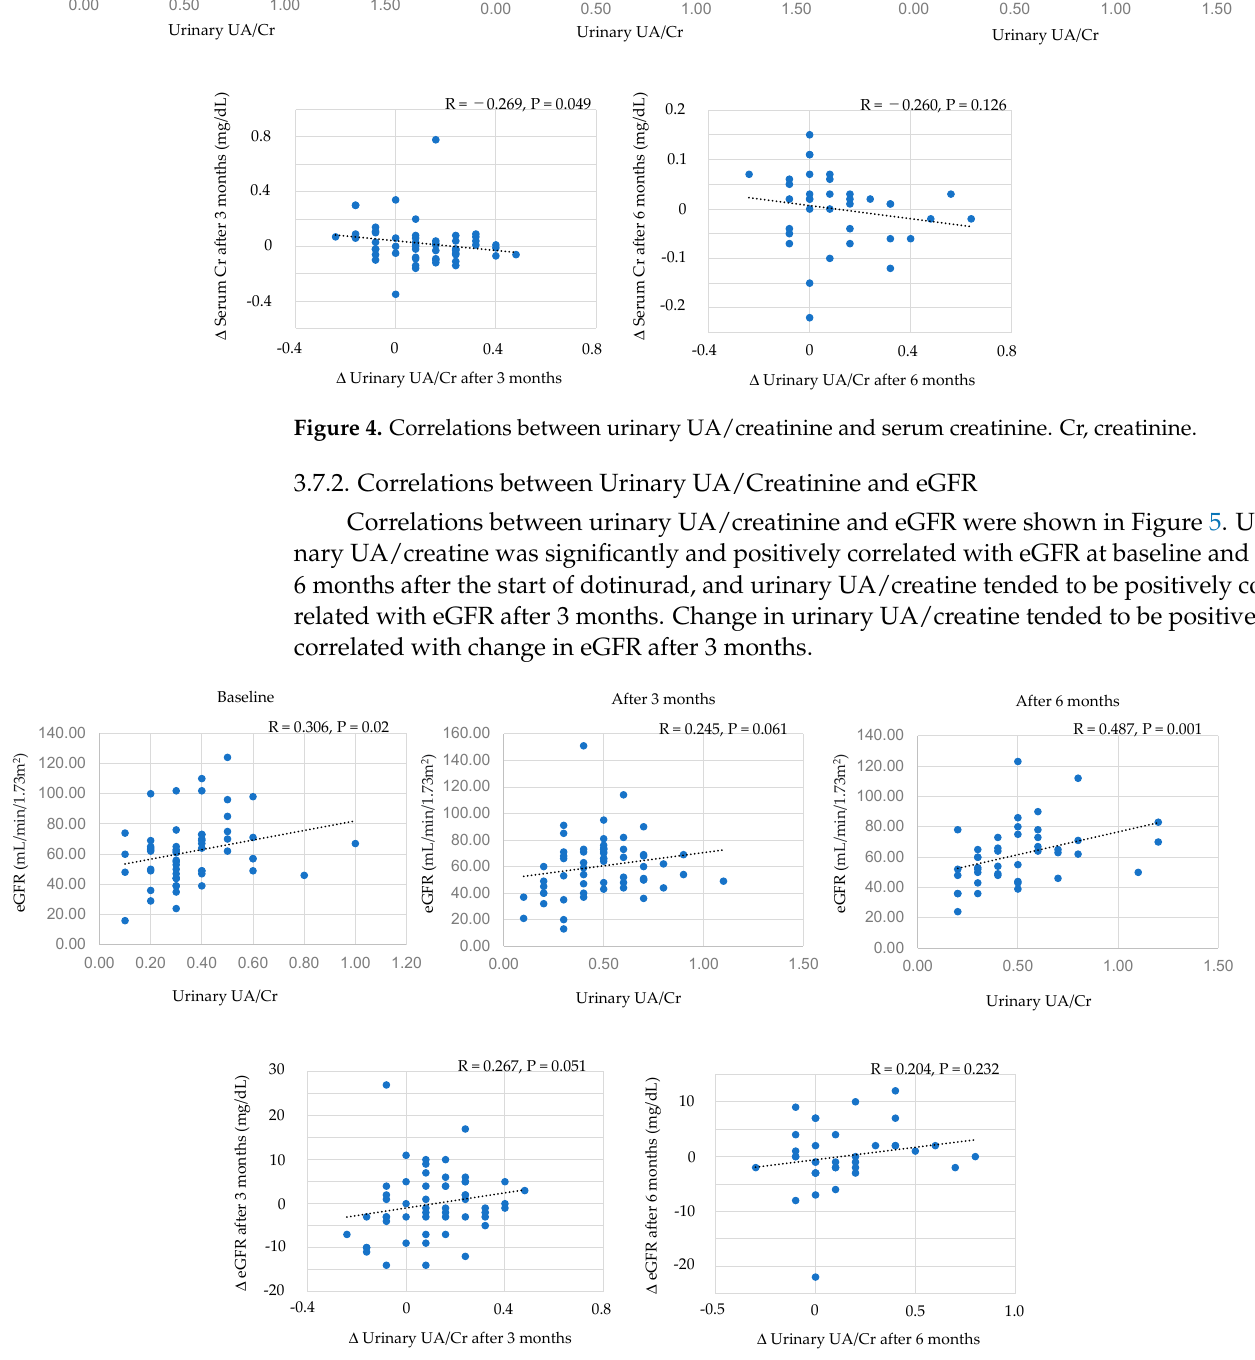
Figure 5. Correlations between urinary UA/creatinine and eGFR. Cr,